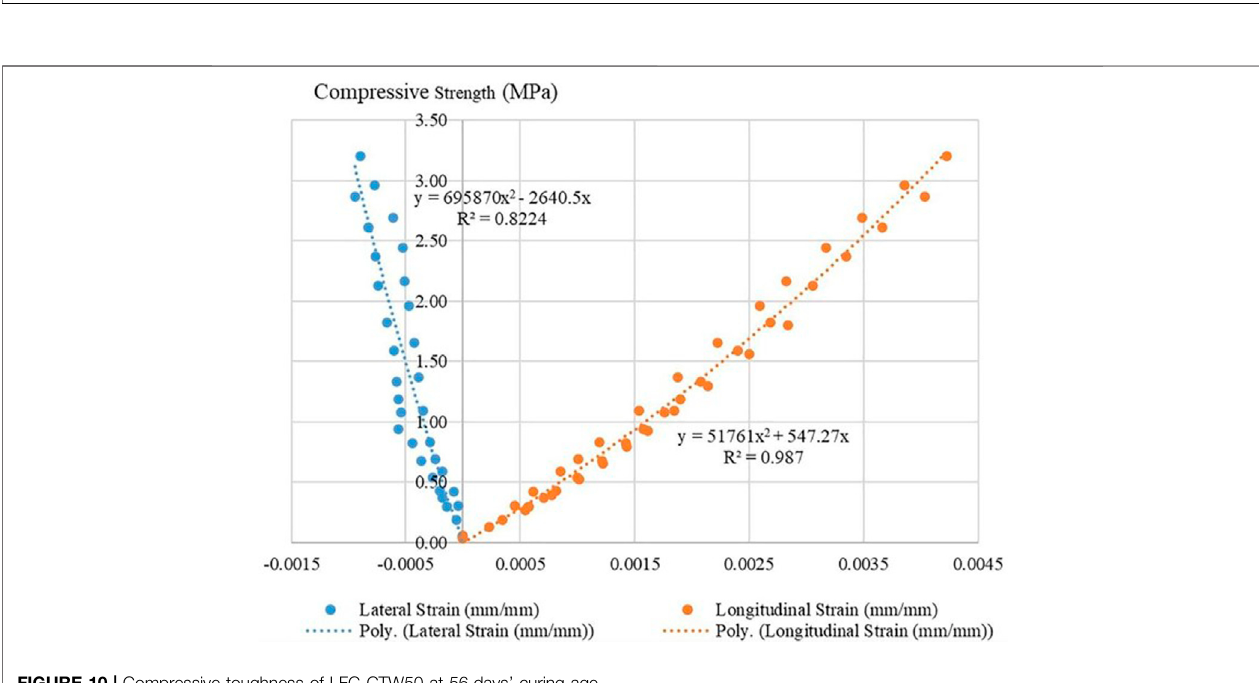
FIGURE 10 | Compressive toughness of LFC-CTW50 at 56 days ’ curing age.